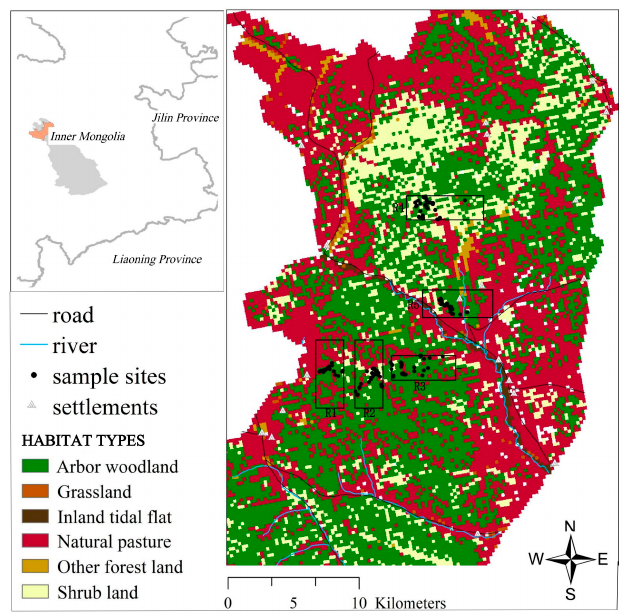
Figure 1. Map of the study area. The points in the figure represent the sampling sites, and R1, R2, R3, R4, and R5 represent five different red deer groups. R1, Xishabutai ( n = 29); R2, Sitehehundi ( n = 57); R3, Shabutai ( n = 55); R4, Luchangxi ( n = 61); R5, Changbu ( n = 29).